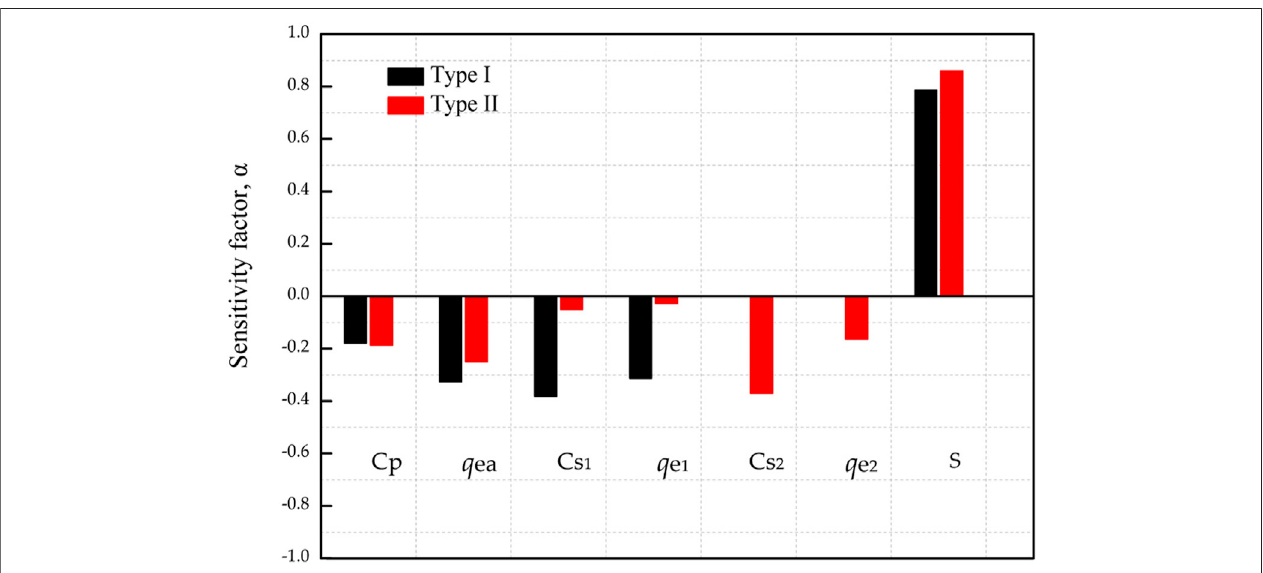
FIGURE 10 | Sensitivity factors for Case